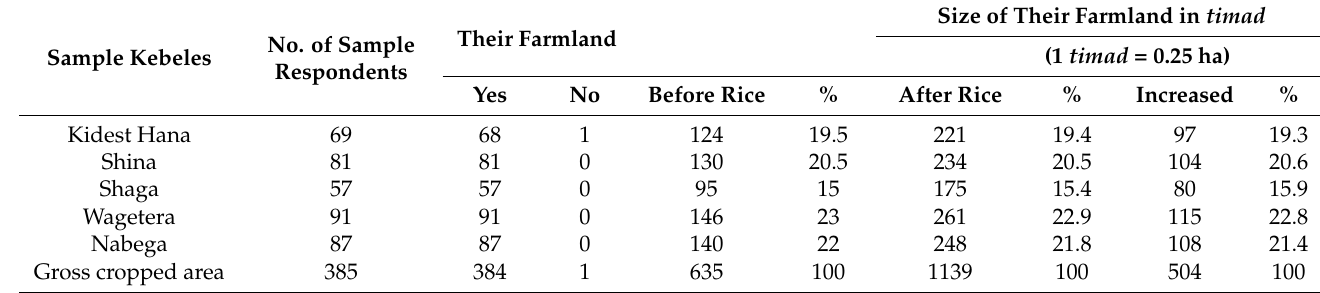
Table 2. Expansion of farmland for rice production.